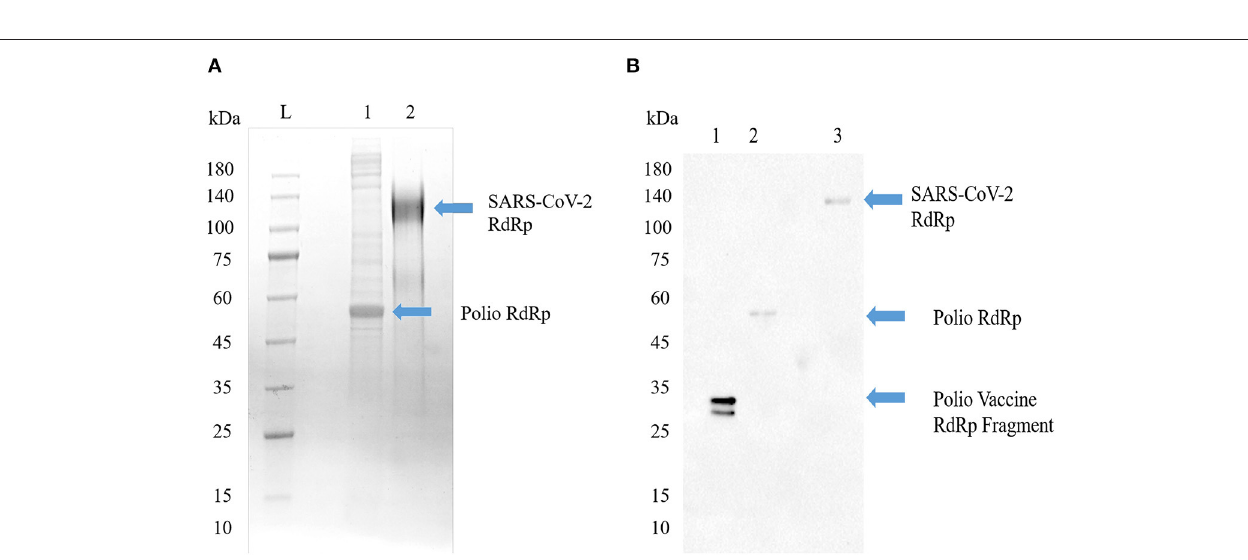
FIGURE 3 | Poliovirus RdRp contains one or more epitopes recognized by SARS-CoV-2 RdRp antibodies. (A) SDS-PAGE image of Poliovirus RdRp proteins from bacterial cells (Lane 1) and full SARS-CoV-2 RdRp (Lane 2). The poliovirus RdRp from bacterial cells seems to be degraded or not post-translationally modified. Both viral forms of the RdRp in their native configuration have been reported to have a molecular weight around 130 kD. (B) Western blot identification of the antigenic activity of RdRp proteins. The primary antibody was a mouse monoclonal antibody to SARS-CoV-2 RdRp protein, and the secondary antibody was a goat anti-mouse IgG/A/M HRP. Lane 1, a vaccine sample shows a line at about 35 kD; Lane 2, poliovirus RdRp expressed in bacterial cells shows a molecular weight around 50–55 kD, representing an un-modified and possibly truncated form of the RdRp; Lane 3, SARS-CoV-2 RdRp, shows a line around 130